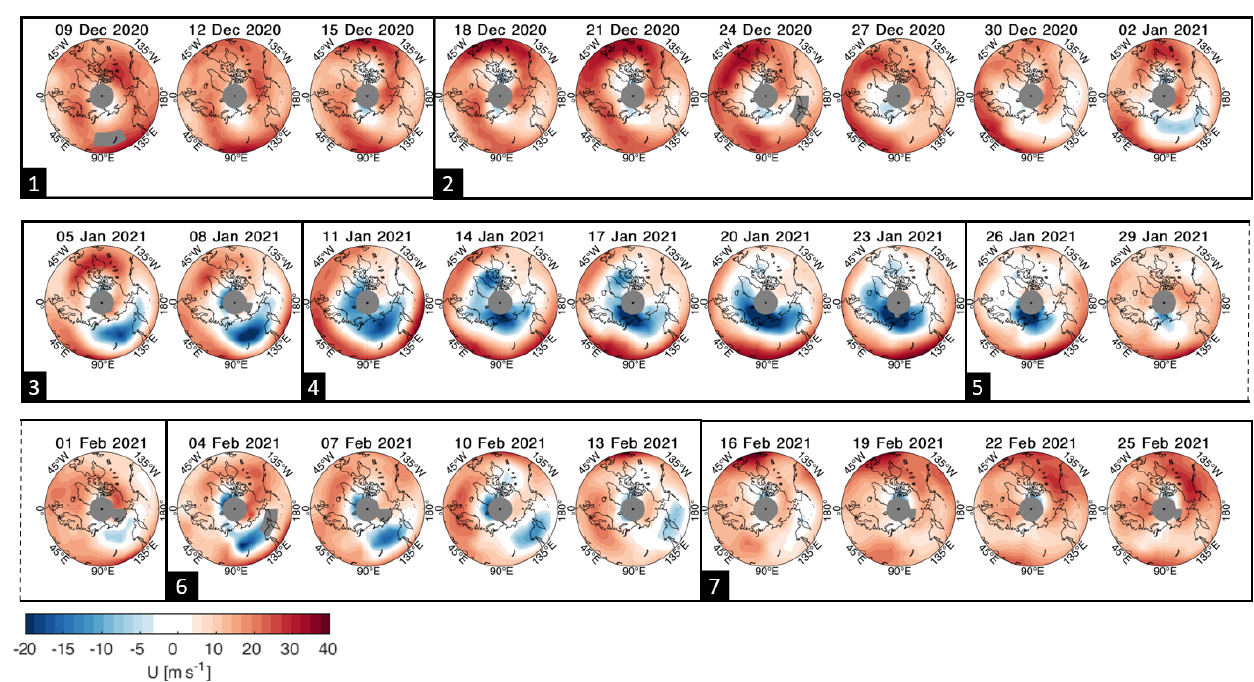
Figure 7. Five-day-mean Aeolus zonal wind at 17km altitude between 45 and 80 ◦ N. Colours show zonal wind speed; note asymmetric colour scale used to better highlight westward winds. Numbered boxes indicate phases of the SSW, defined to help guide discussion in Sect.